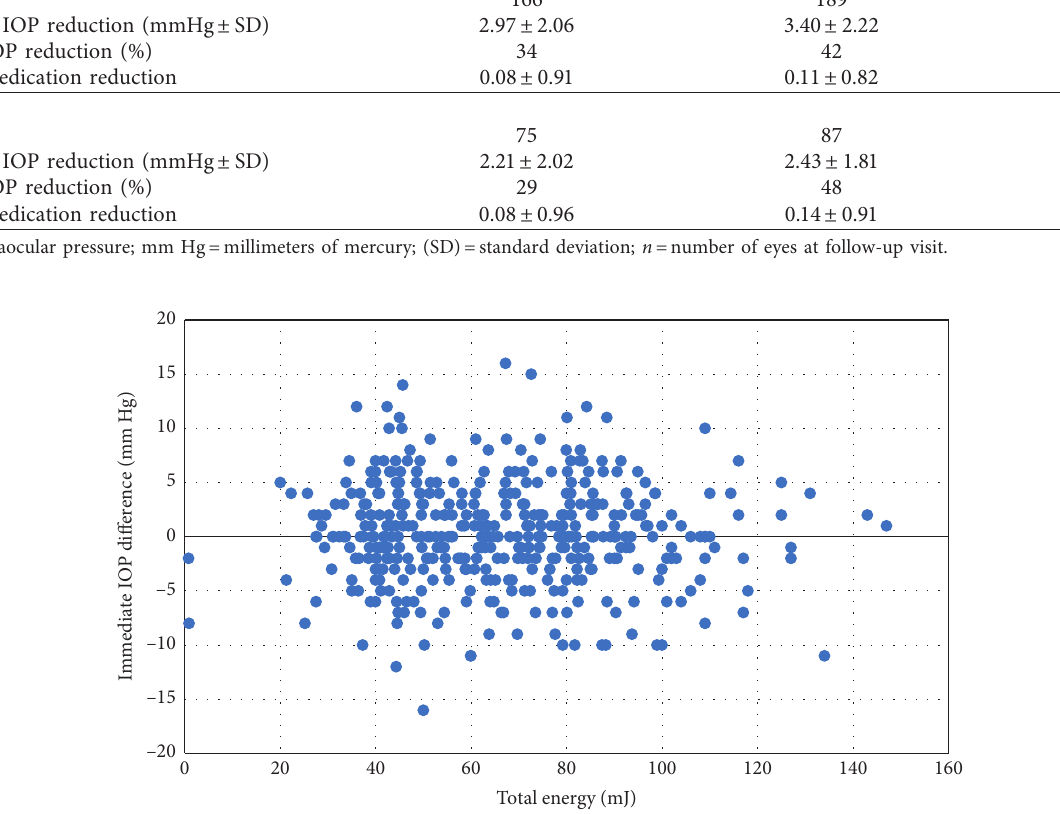
Figure 2: Difference in IOP immediately following SLT and the total energy level of the laser. There was no correlation between the total energy level of the laser and the immediate IOP difference ( r � − 0.01) CI [ − 0.085, 0.105] ( p � 0 . 837). IOP � intraocular pressure; SLT � Selective Laser Trabeculoplasty; r � Pearson correlation coefficient; CI � confidence interval.